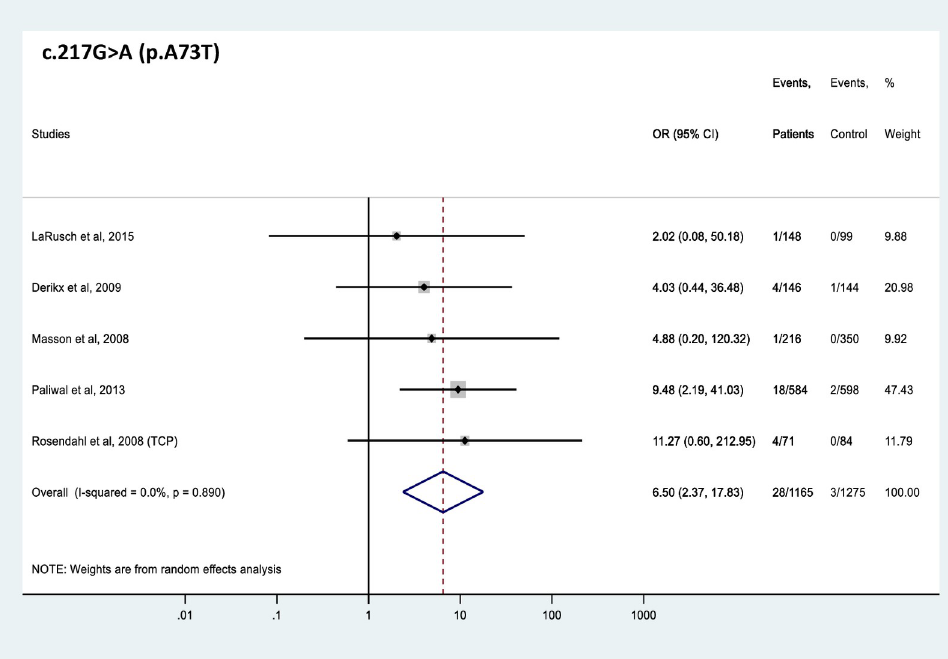
Fig 2. Forest plot showing odds ratios for pancreatitis risk in patients carrying the c.217G > A (p.A73T) CTRC variant. OR, odds ratio; CI, confidence interval.